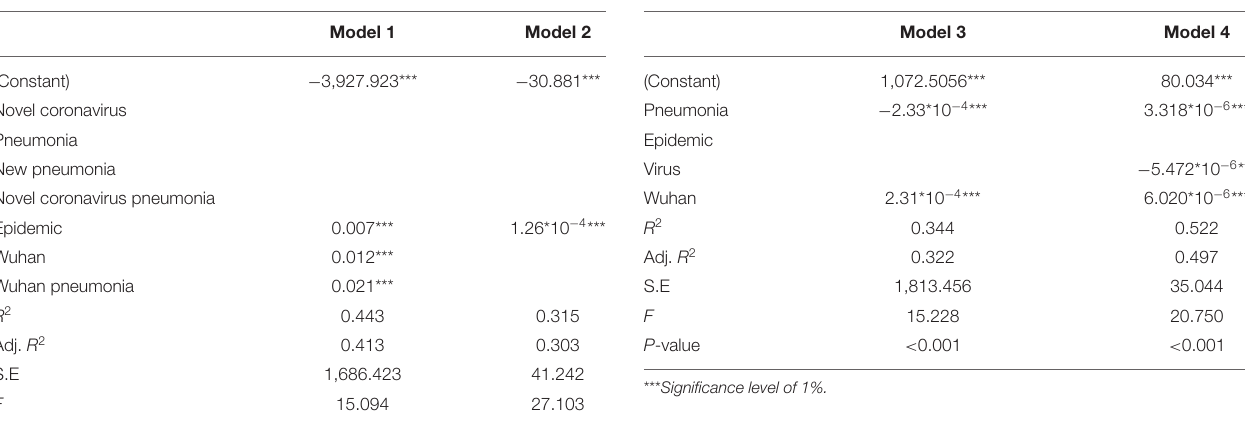
TABLE 3 | Forecast results of model 3 and model 4.